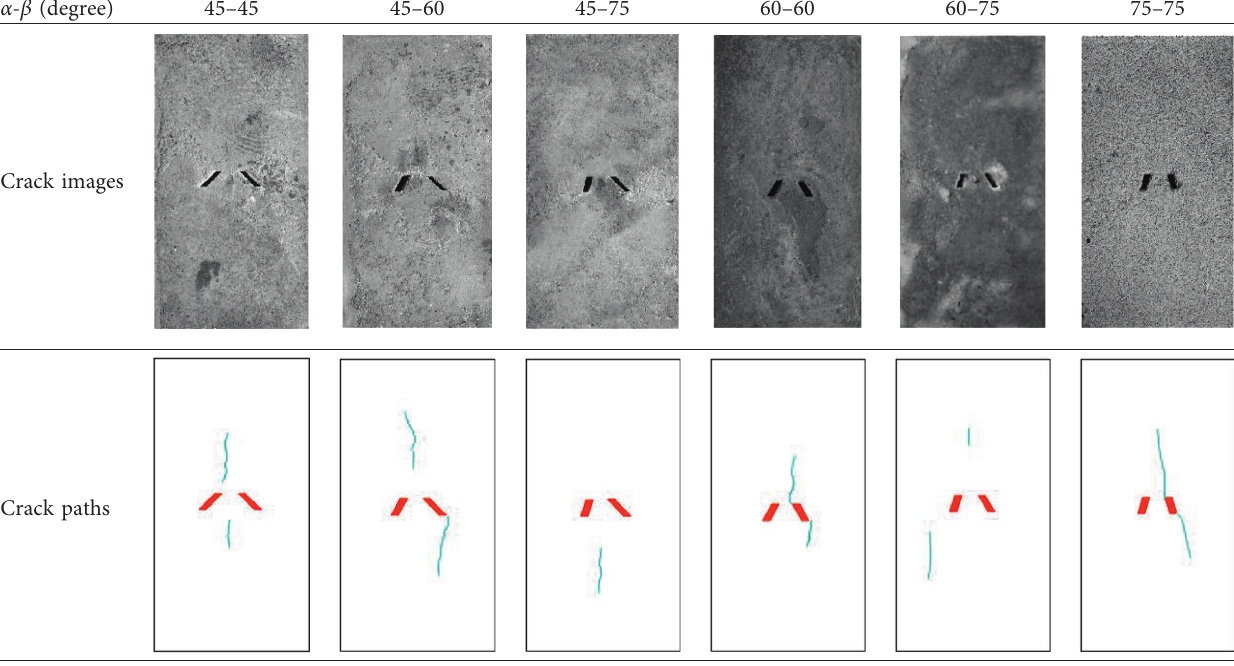
Table 2: Macro first cracks initiated from the specimens containing two parallelogram flaws with different inclination angles under uniaxial